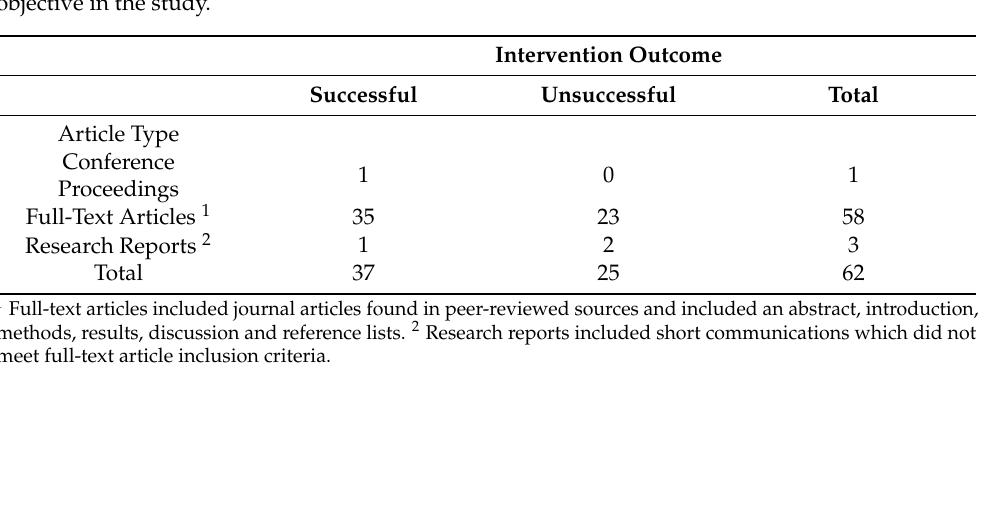
Figure 3. Number of studies which included interventions and the level at which the intervention was applied. Table 1. Article type including an intervention used and intervention outcome based on stated objective in the